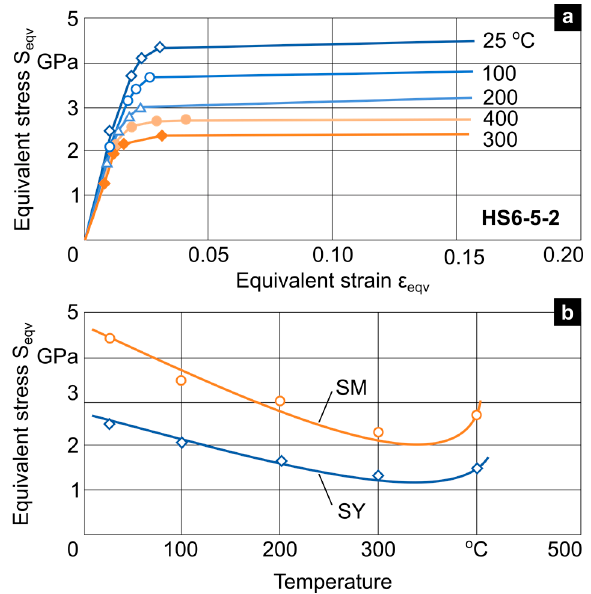
Figure 4. ( a ) Stress–strain curve of the applied HSS, attained via an FEM supported evaluation of nanoindentation results at elevated temperatures; ( b ) course of the yield (SY) and rupture stress (SM) of the HSS versus the temperature.